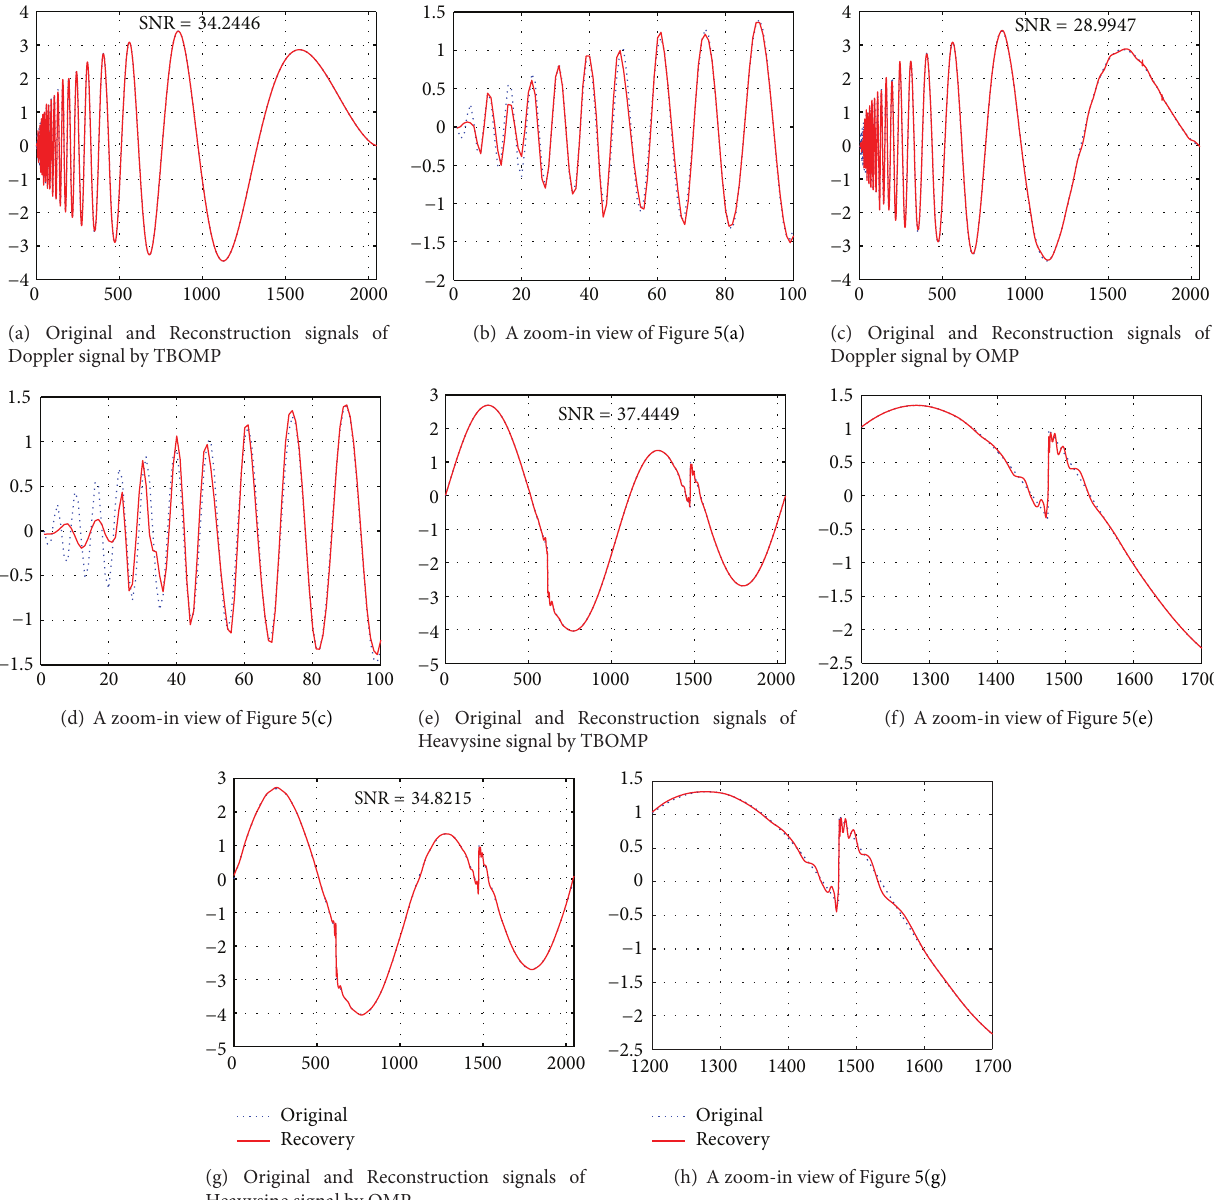
Figure 5: Reconstruction results of Doppler and HeavySine signal by TBOMP and OMP